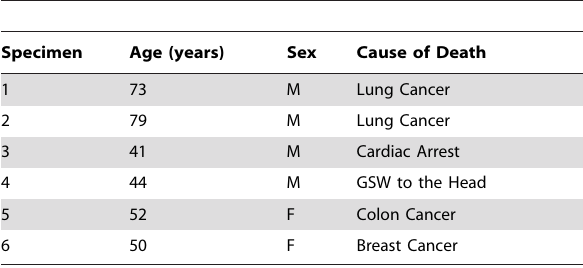
Abbreviations: M= Male, F= Female.